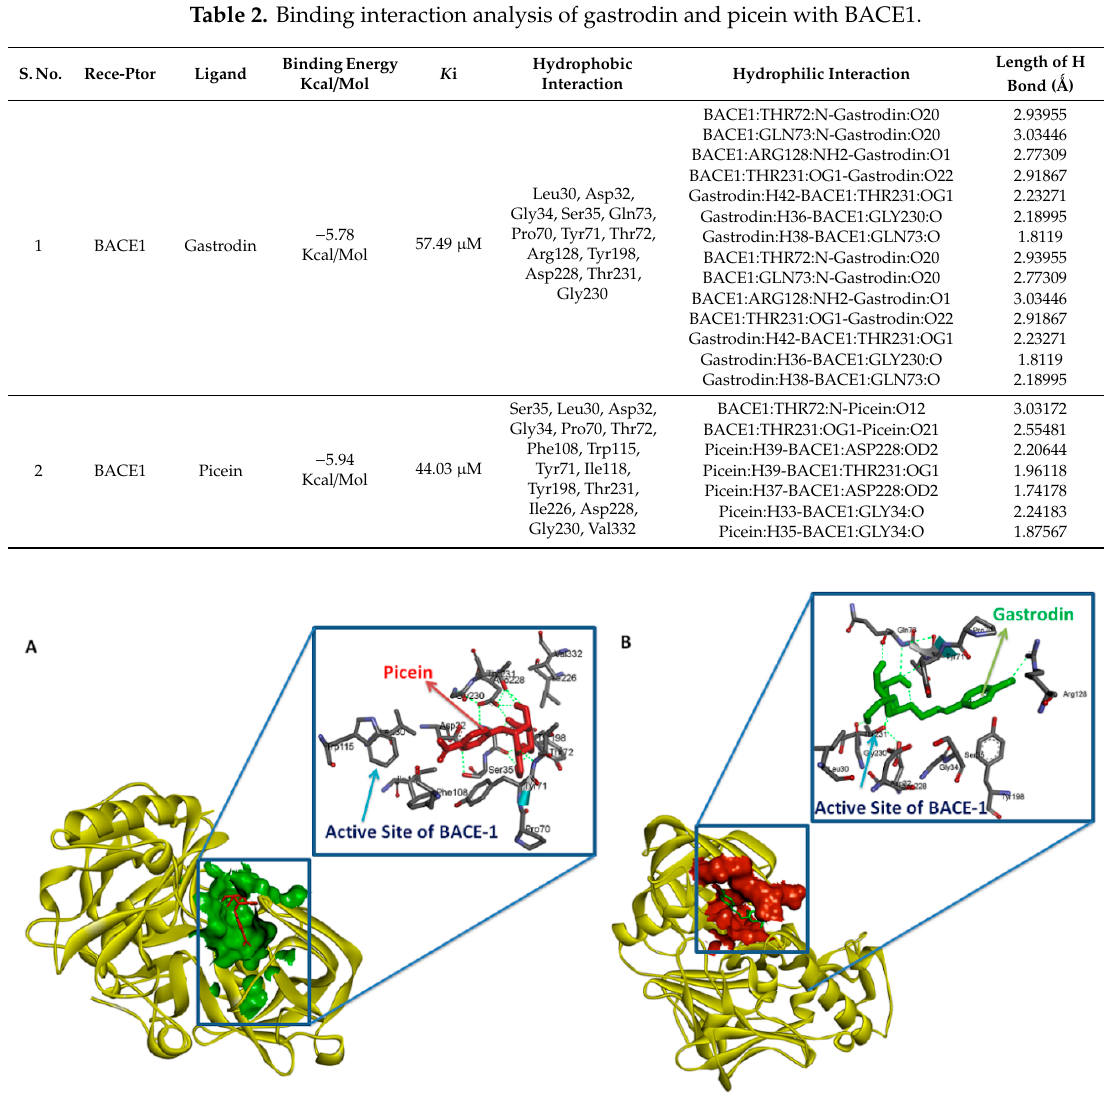
Figure 3. Binding interaction pattern and poses of gastrodin with BACE1 ( A ) and picein with BACE1 ( B ), where picein ( − 5.94 Kcal/Mol) is exhibiting stronger binding affinity than gastrodin ( − 5.78 Kcal/Mol). Both of ligands share almost the same binding site.